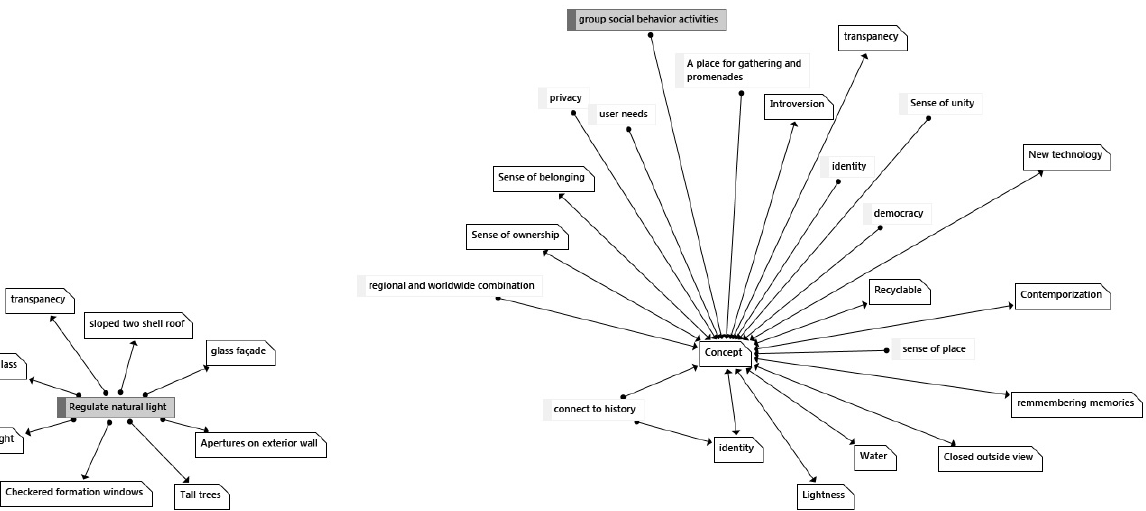
Figure 17. Codes related to community architecture concepts in contemporary Figure 16. Codes related to light in architecture of Iran – 1978–2000 (source: authors) contemporary Iranian architecture (source: authors)